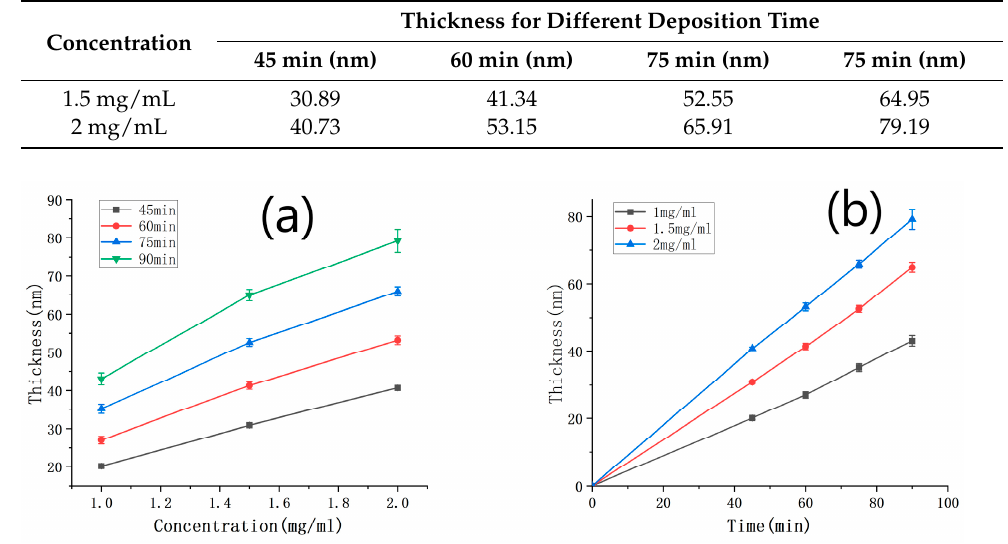
Figure 6. Curve of PDA fi lm thickness against the concentration of the dopamine solution, with the deposition time as a parameter; ( b ) curve of PDA fi lm thickness with the deposition time, under di ff erent concentrations. different